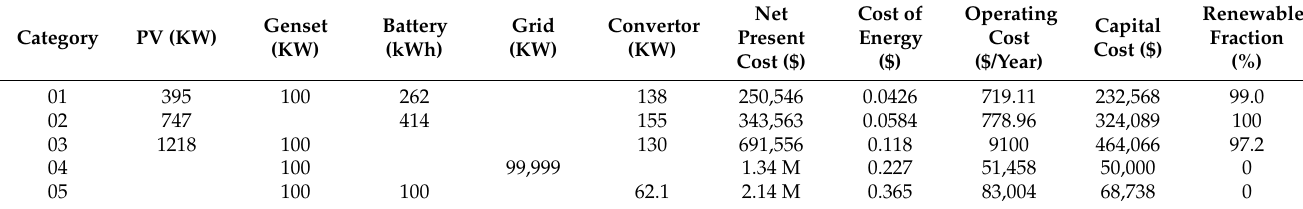
Table 3. Optimized design of microgrid proposed by